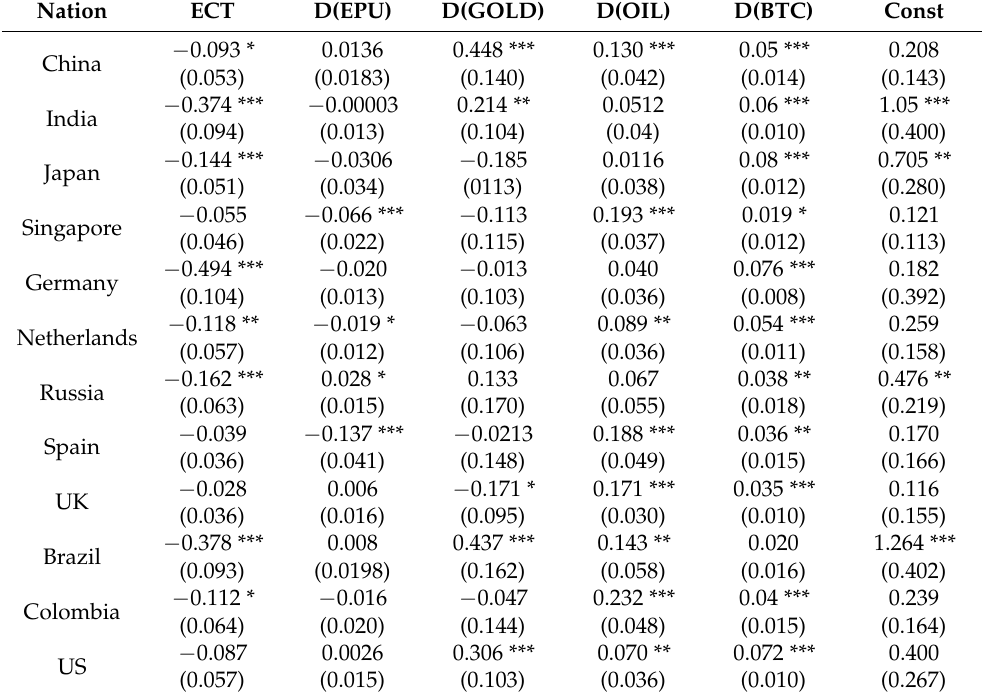
Table 7. PMG individual nation